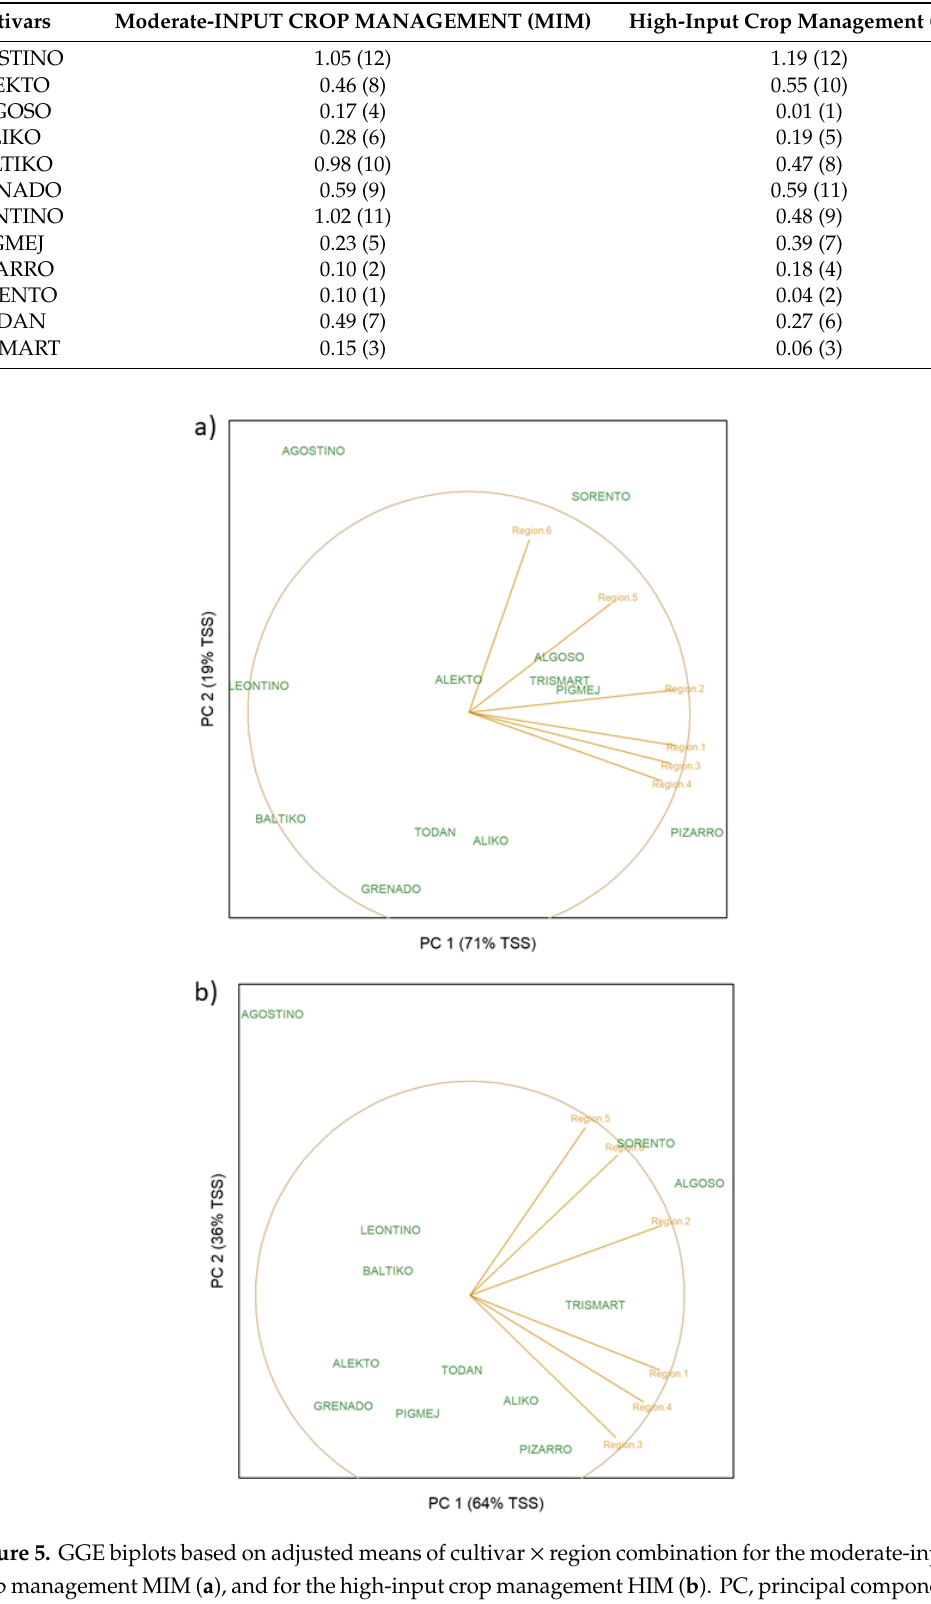
Table 4. The results of the superiority measure of yielding (Pi) for 12 triticale cultivars, separately for two crop managements through six regions. There is a ranking of cultivars in brackets.